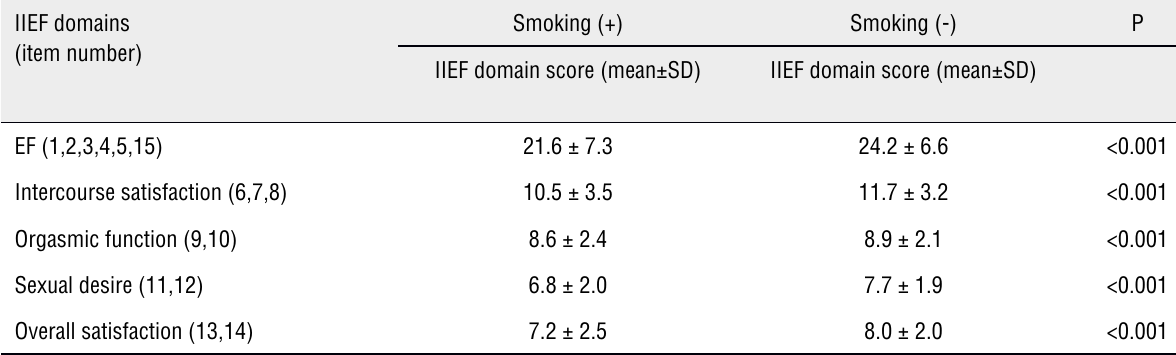
Table 2 - Comparison of the IIEF domain scores before and after smoking cessation.